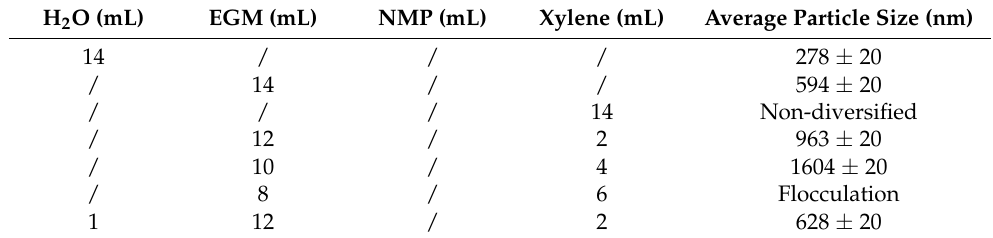
Table 1. Dispersion of GO in single/mixed-solvent